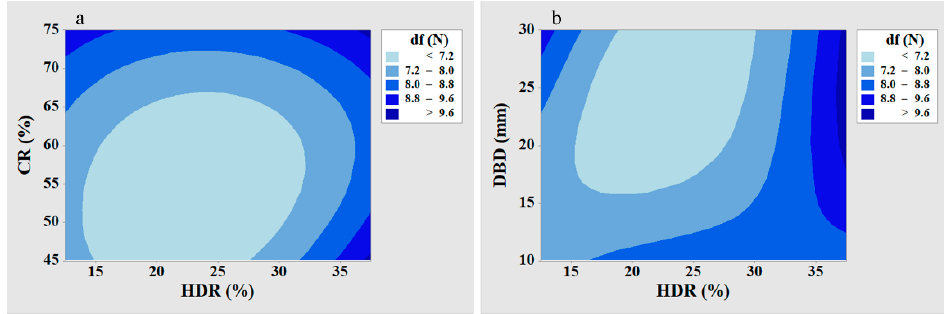
Figure 5. Effect of control parameters on sliding resistance according to an L9 (3 3 ) Taguchi orthogo- nal array: ( a ) contour plot of sliding resistance vs. CR, HDR; ( b ) contour plot of sliding resistance vs. DBD, HDR.